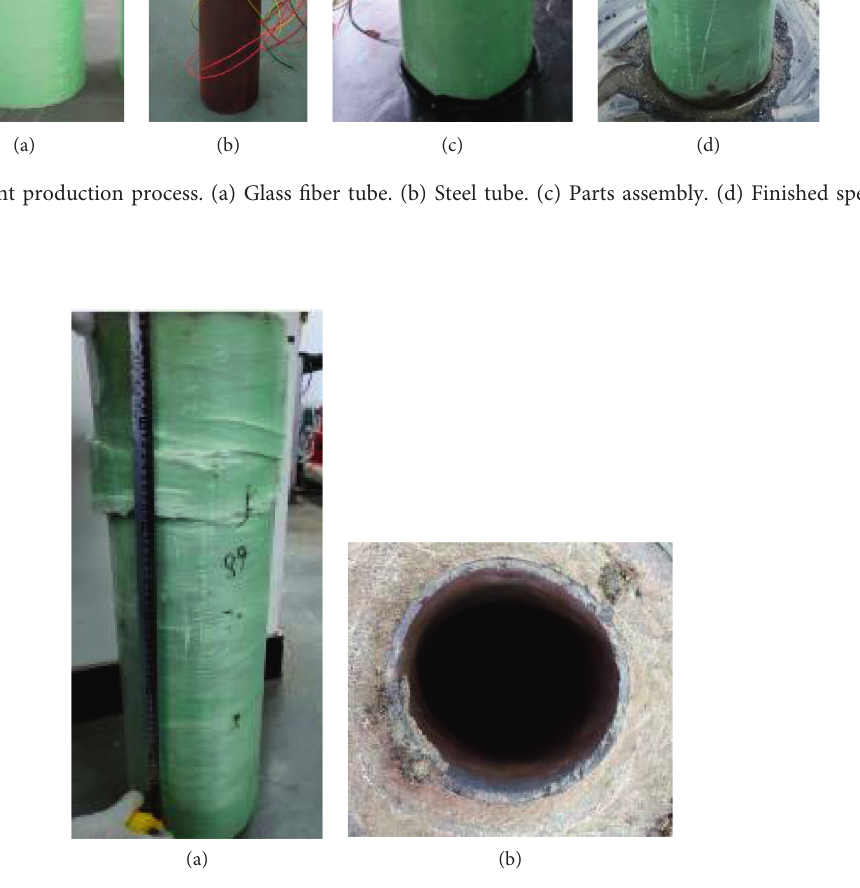
Figure 7: Failure mode of specimen GGCS1. (a) GFRP tube. (b) Steel